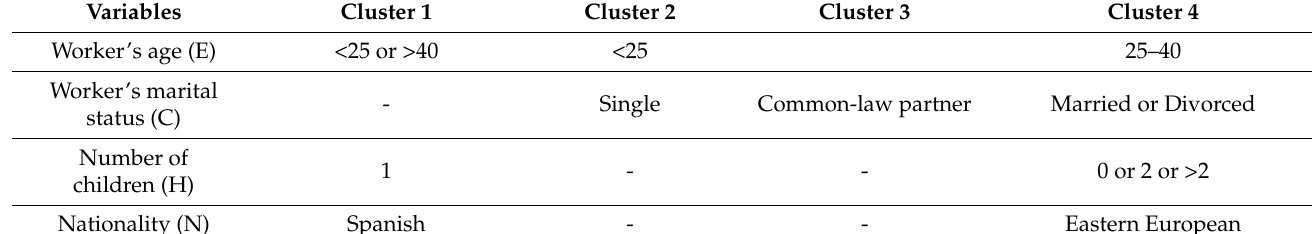
Table 6. Description of the four identified clusters of the variable